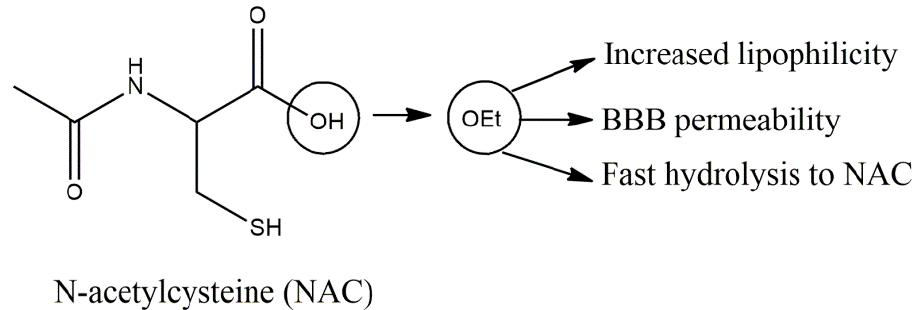
Figure 8. N-acetylcysteine and the properties of its ethyl ester.